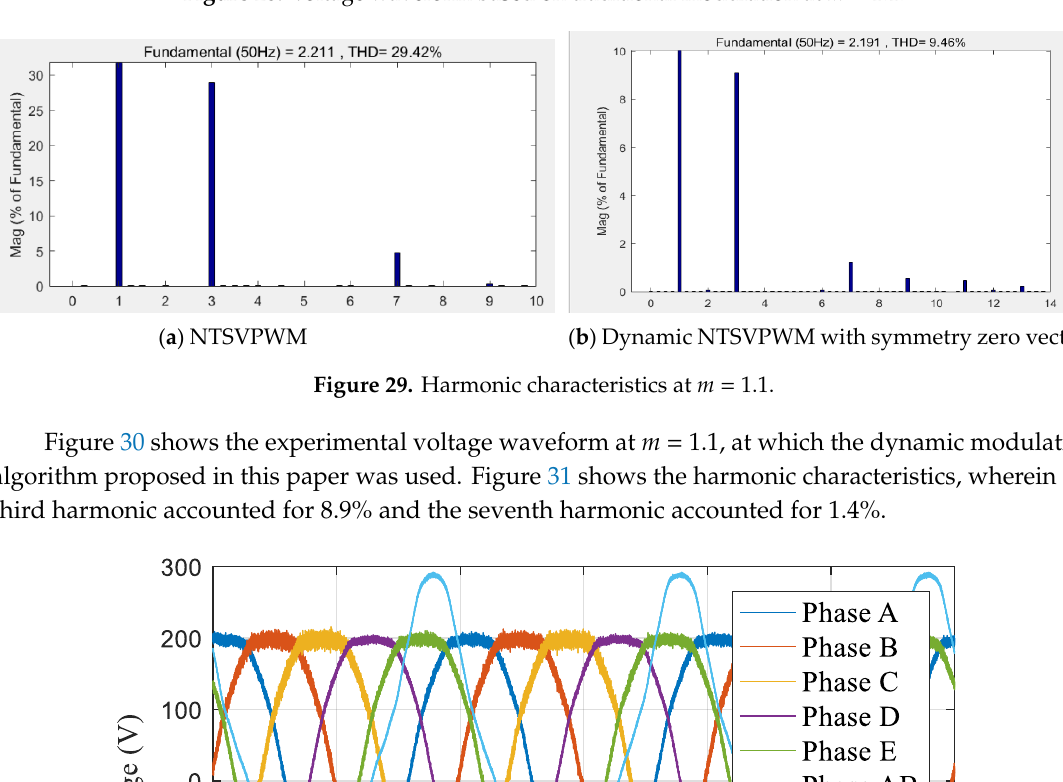
= 1.1. Energies 2019 , 12 , x FOR PEER REVIEW